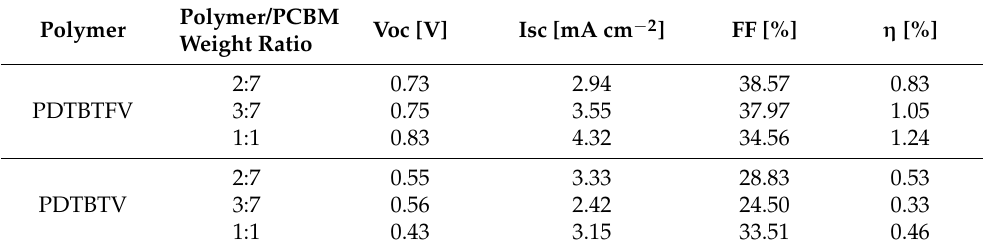
Table 1. Photovoltaic performance of BHJ solar cells of PDTBTFV and PDTBTV in blend with PCBM: open circuit voltage Voc; short circuit current Isc; fill factor FF and power conversion efficiency η .